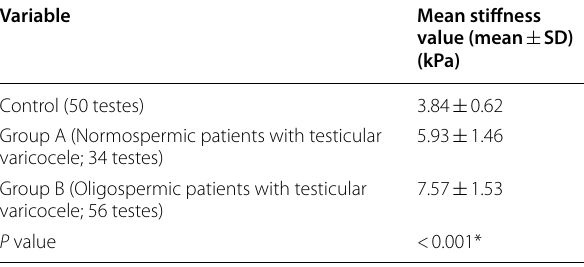
Table 2 Mean testicular stiffness (elasticity) among patients groups (A, B) and healthy controls